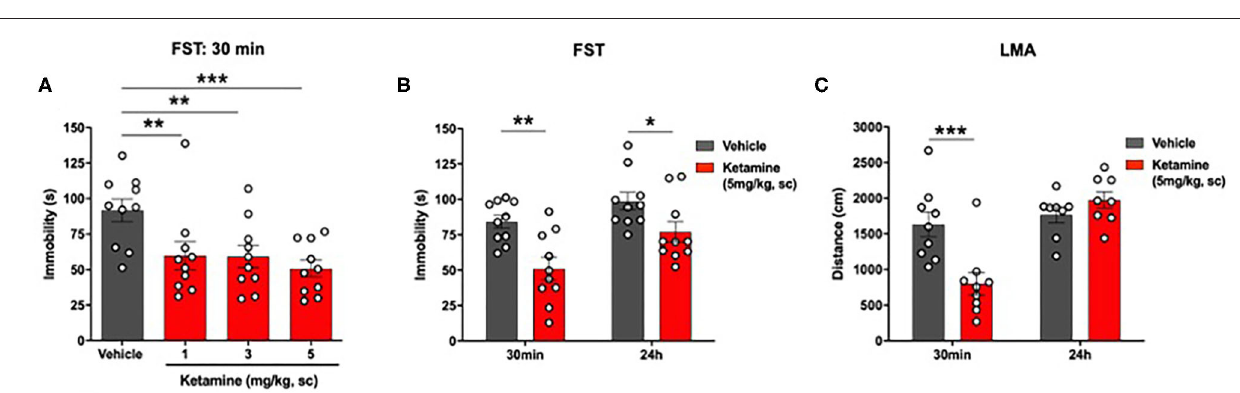
FIGURE 2 | Concentration of ketamine in plasma and brain. (A) Plasma drug exposure 36min post-administration of ketamine (1, 3, and 5 mg/kg, s.c.). (B) Time course of plasma drug exposure post-administration of ketamine 5 mg/kg, s.c. (C) Time course of brain drug exposure post-administration of ketamine 5 mg/kg, s.c. Data are expressed as mean ± SEM, n = 3 per group.